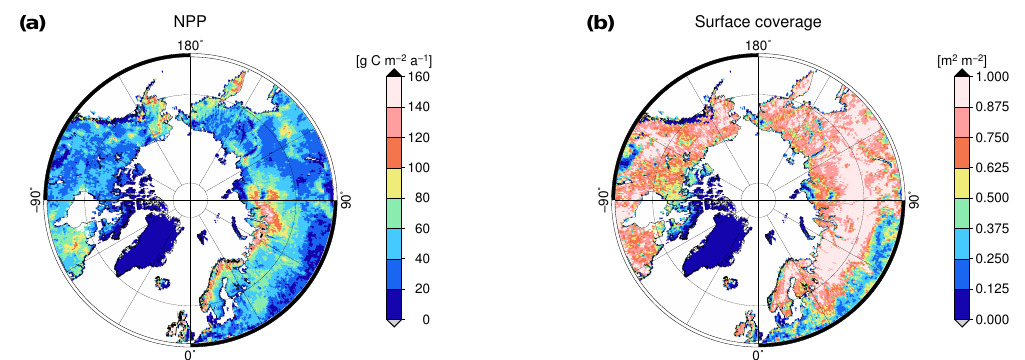
Figure 4. Large-scale patterns of (a) NPP and (b) surface coverage of bryophytes and lichens simulated in JSBACH. The values in the grid cells are calculated by averaging the last 15 years of a 1901 to 2010 dynamic simulation. g C stands for “gram carbon”.